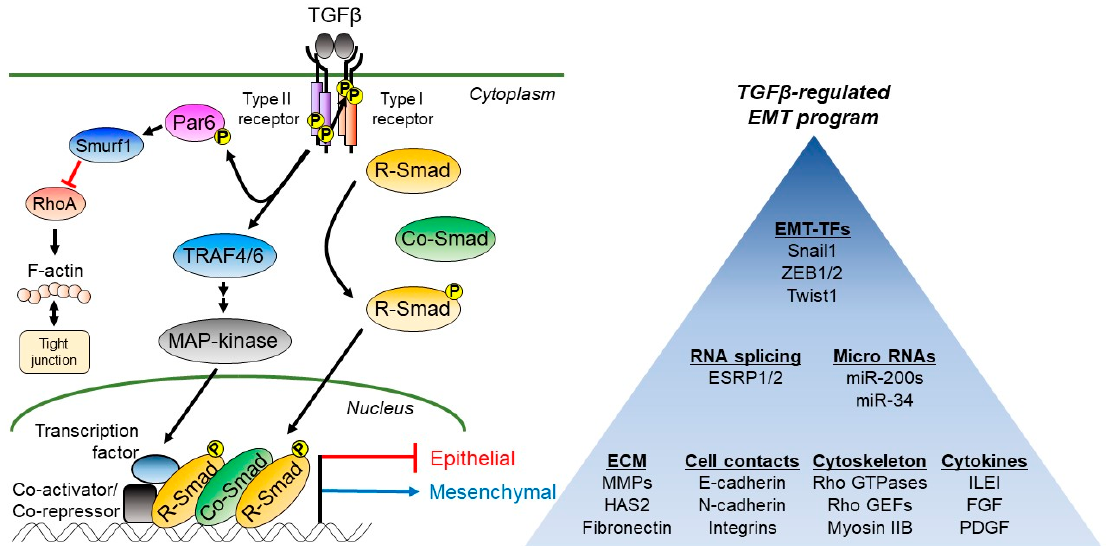
Figure 2. Basic TGF β signaling diagram along with a program of TGF β -regulated genes that contribute to the EMT. Left side, the extracellular dimeric TGF β ligand is shown to bind to its plasma membrane receptors, the type II and type I receptors (each drawn as a dimer), causing trans-phosphorylation (circled P) of the type I receptor by the type II receptor. The type II receptor phosphorylates the polarity protein Par6, which recruits the ubiquitin ligase Smurf1 and regulates RhoA-dependent actin assembly and tight junction disassembly. The type I receptor also recruits the ubiquitin ligases TRAF4 and TRAF6, which activate the MAP-kinase pathway by ubiquitination, leading to the transcription factor phosphorylation. The type I receptor kinase also phosphorylates R-Smads, which form complexes with the Co-Smad, Smad4. In the nucleus, Smad complexes and cooperating transcription factors bound to various genes, along with co-repressors (co-activators) either repress the expression of epithelial genes or induce the expression of mesenchymal genes. Right side, a summary of the TGF β -regulated EMT program divided into seven subprograms, each enlisting only a small representative example of genes that are involved in the EMT and cell motility. Signaling flow is indicated by black arrows (positive flow) and red T-bars (negative regulation); on the gene transcriptional start site, a red T-bar indicates negative regulation and a blue arrow indicates positive regulation of transcription.